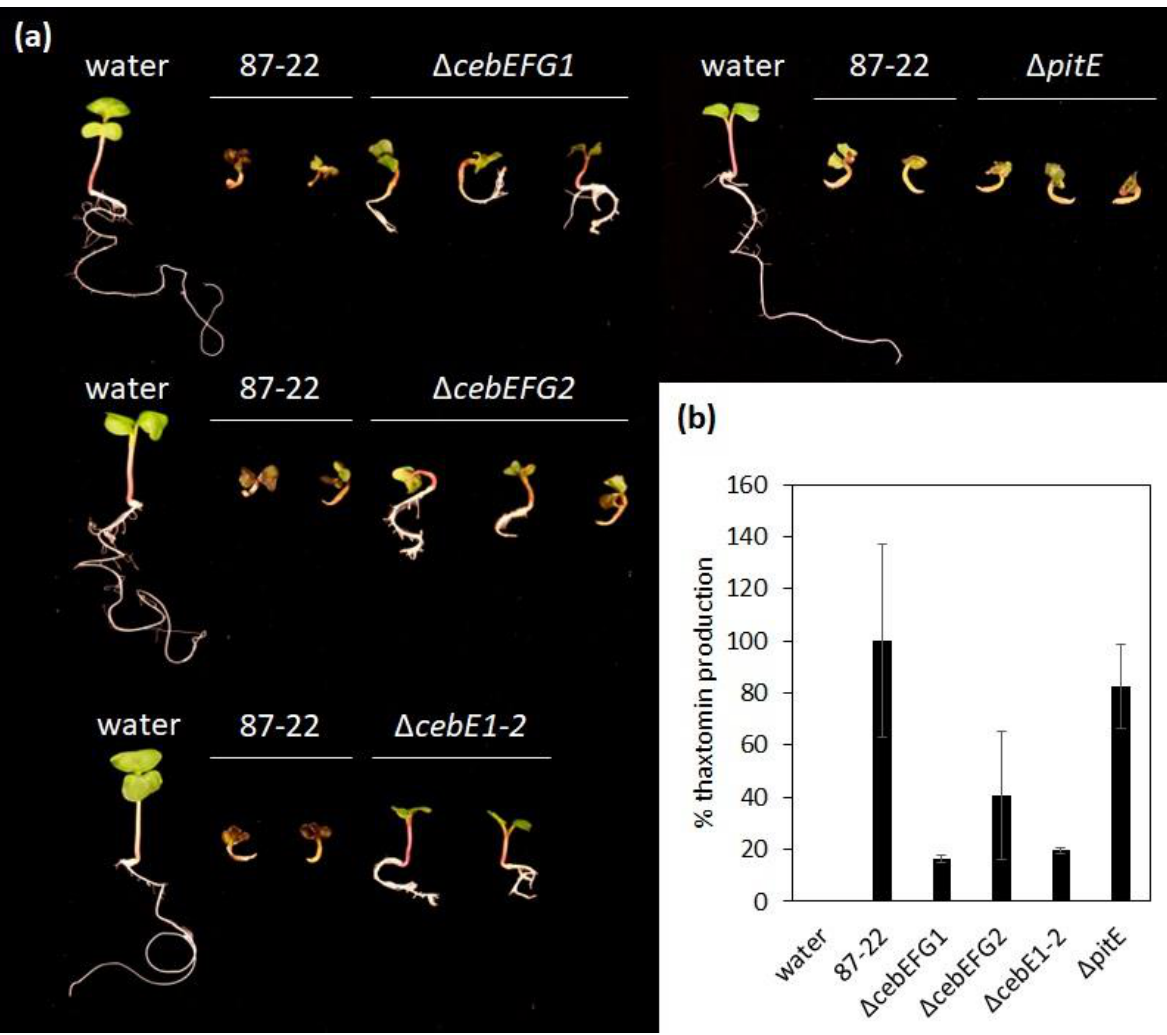
Figure 5. ( a ) Radish seedling assays showing the reduced virulence of the transporter deletion mutant strains compared to the wild type (87-22) at 7 dpi; ( b ) Thaxtomin levels as extracted from the radish seedling assay at 7 dpi and analyzed by HPLC. Thaxtomin levels produced by the wild type were set as 100%.